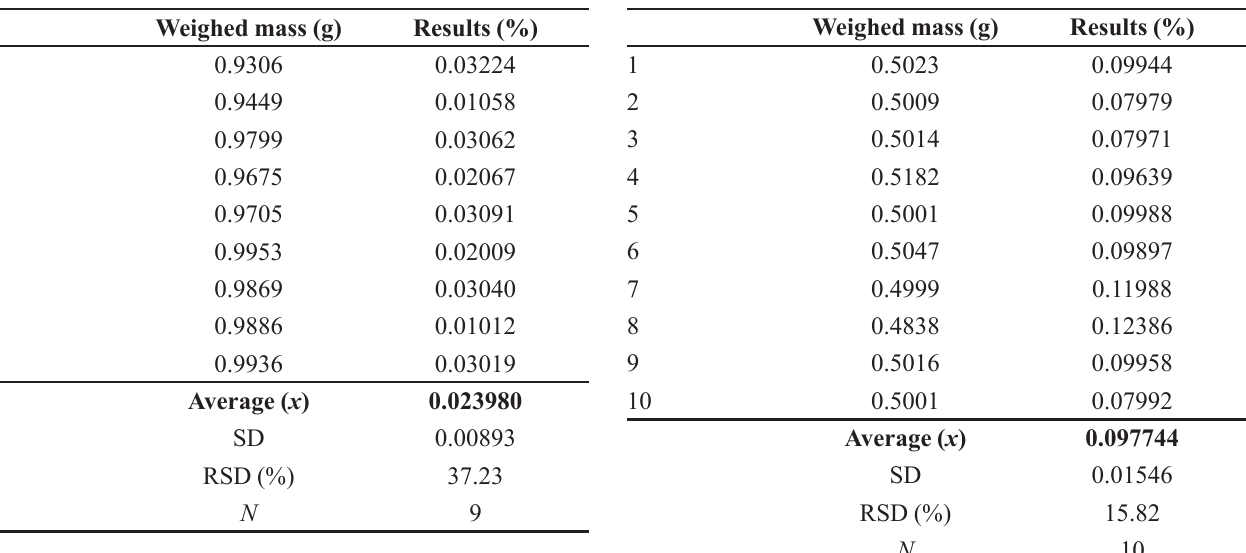
TABLE I - Results for the residue of ignition test TABLE II - Results for loss on drying